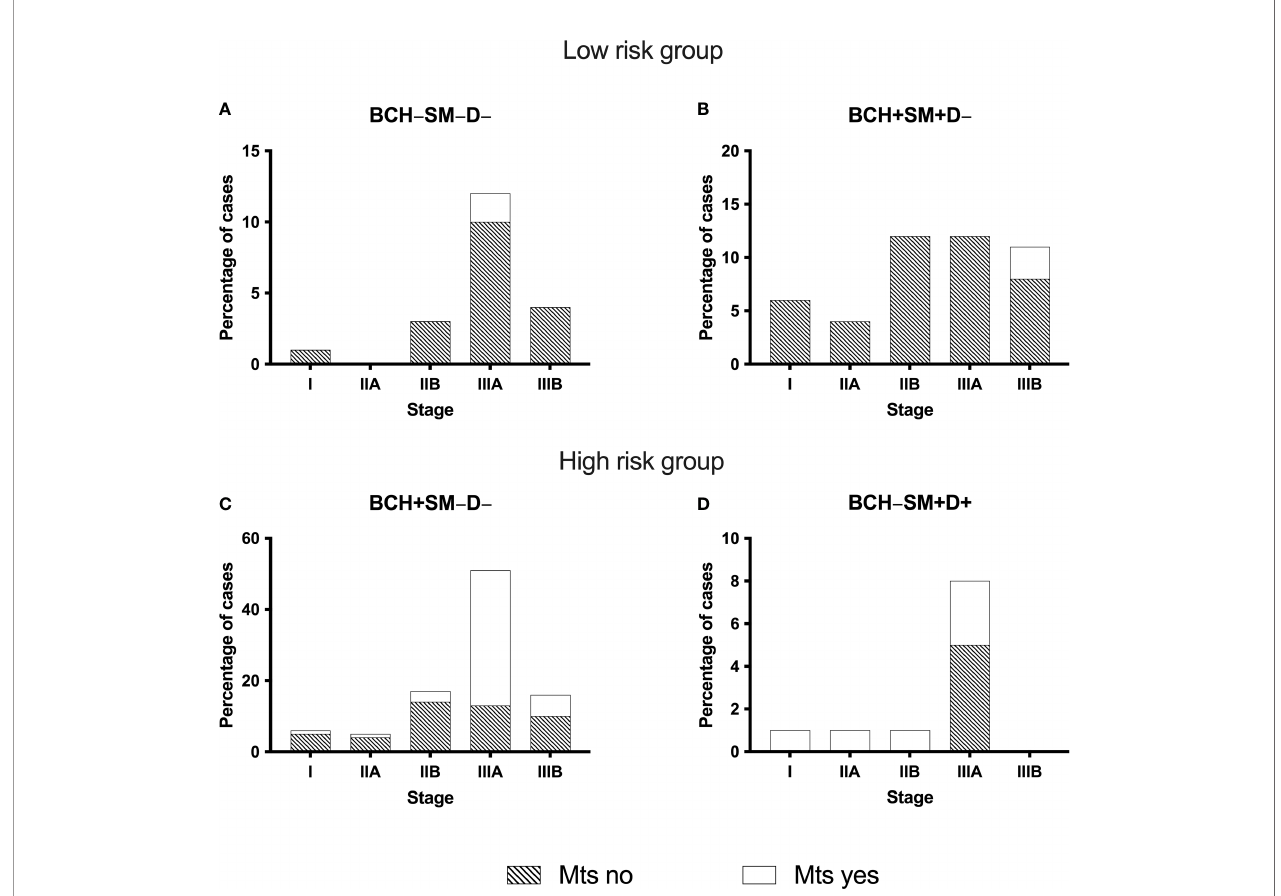
FIGURE 3 | The frequency of distant metastases in NSCLC patients with different bronchial lesions (A – D) depending on the cancer stage. BCH, basal cell hyperplasia; SM, squamous metaplasia; D, dysplasia; Mts, distant metastases; NSCLC, non-small cell lung